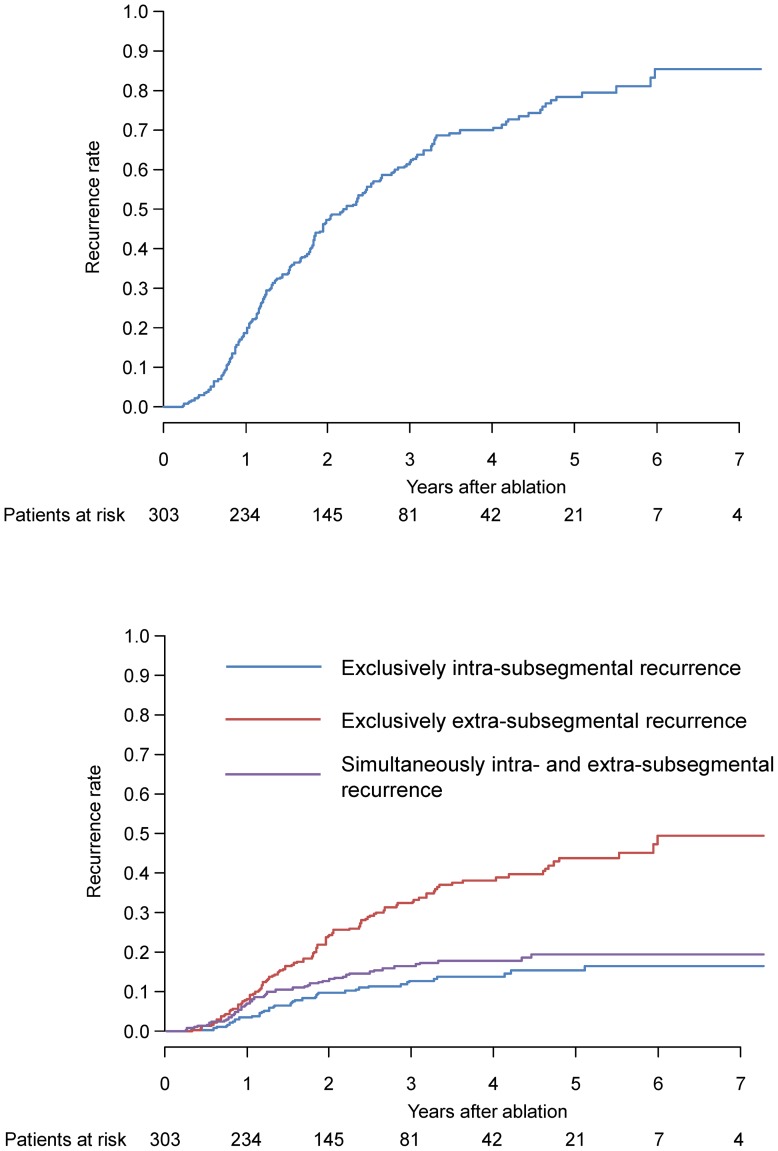

Figure 2A:
 Overall recurrence.
Figure 2B:
 Recurrence rates of according to the mode of recurrence.